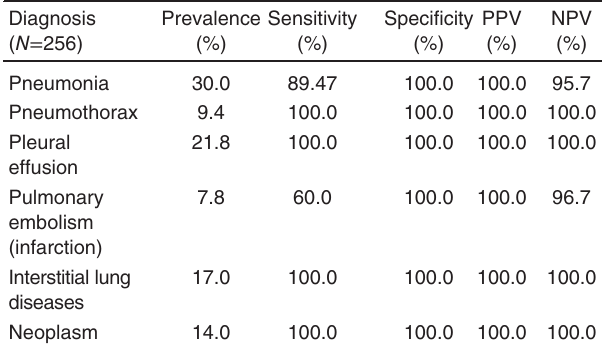
Table 7 Statistical comparison between chest radiography and chest ultrasonography as a diagnostic tool in parenchymal, pleural, and vascular lung